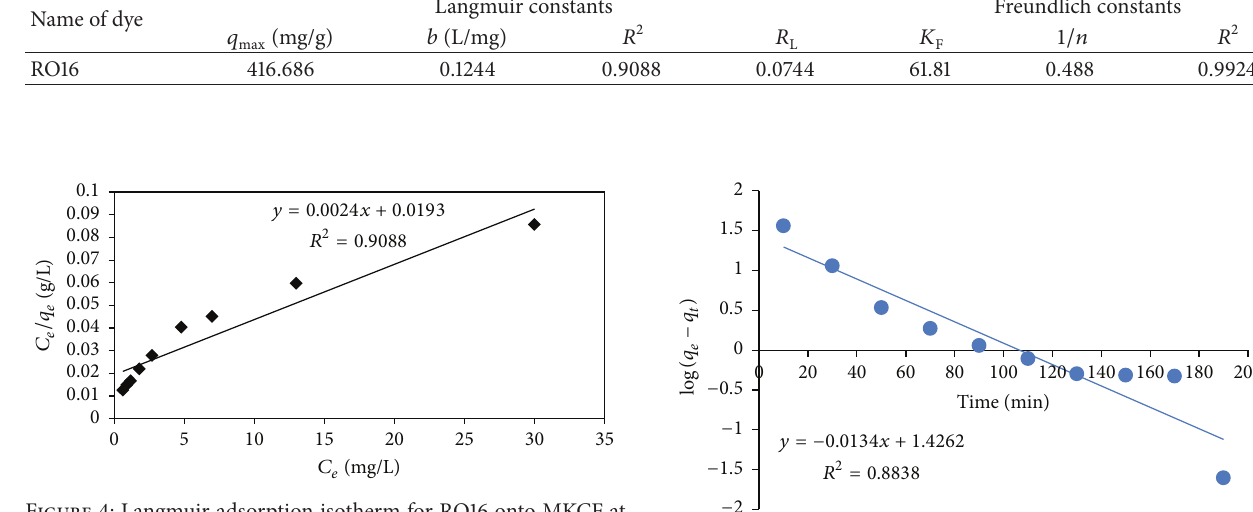
Figure 4: Langmuir adsorption isotherm for RO16 onto MKCF at 30 ∘ C.